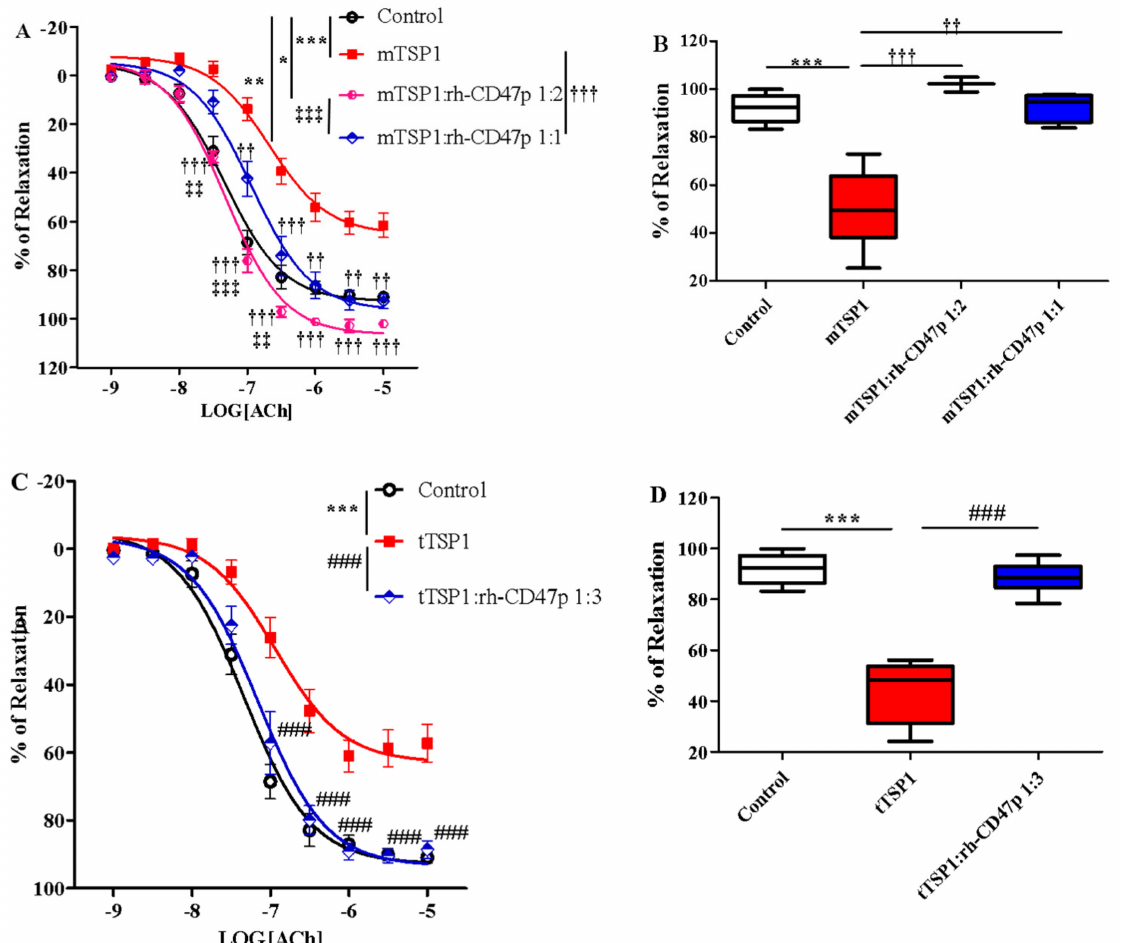
Figure 4. Pretreatment with recombinant human CD47 peptide (rh-CD47p) effectively prevents TSP1-blunted